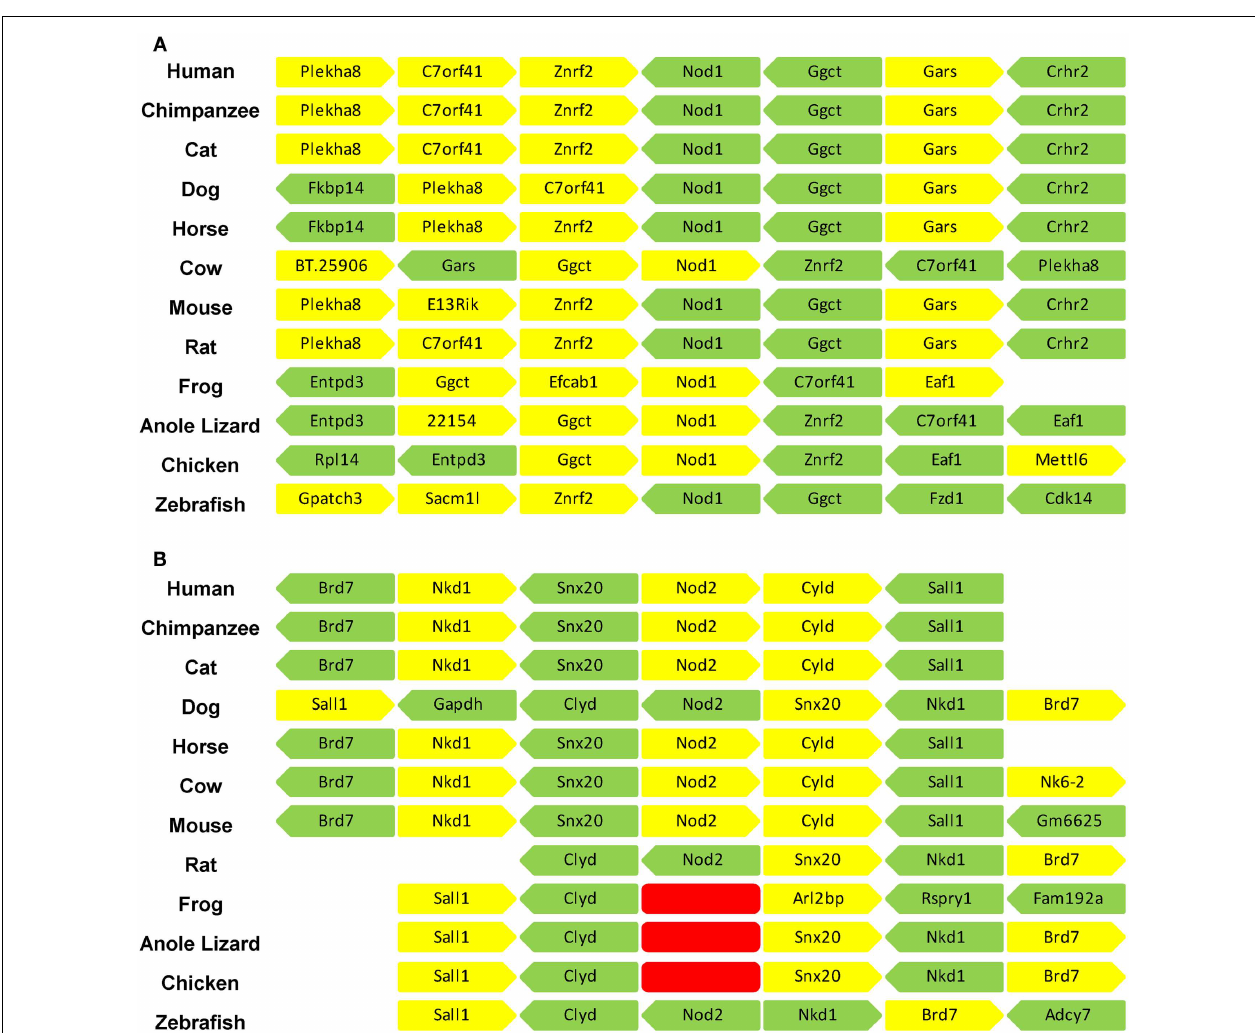
FIGURE 1 |The syntenic positions of Nod1 and Nod2 are highly conserved .The syntenic position of (A) Nod1 and (B) Nod2 were compared in 12 different vertebrate species.The three adjacent genes upstream and downstream of Nod1/2 are displayed. Each gene is represented by an individual block with yellow denoting a position on the forward strand and green a position on the reverse strand. A space indicates insufficient information to definitively identify the gene in that location.The red blocks in (B) indicate the absence of the Nod2 gene from the frog, anole lizard, and chicken genomes. Gene identities are as follows: Plekha8 – pleckstrin homology domain containing, family